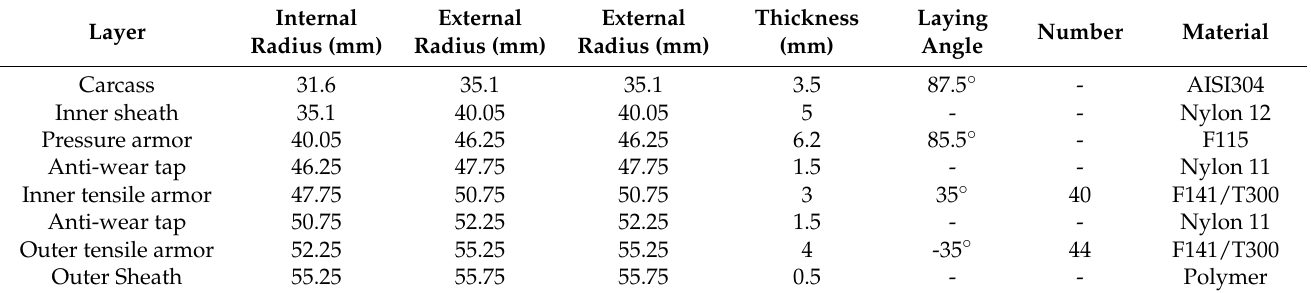
Table 1. Parameters of the unbonded flexible riser with a composite reinforced layer.